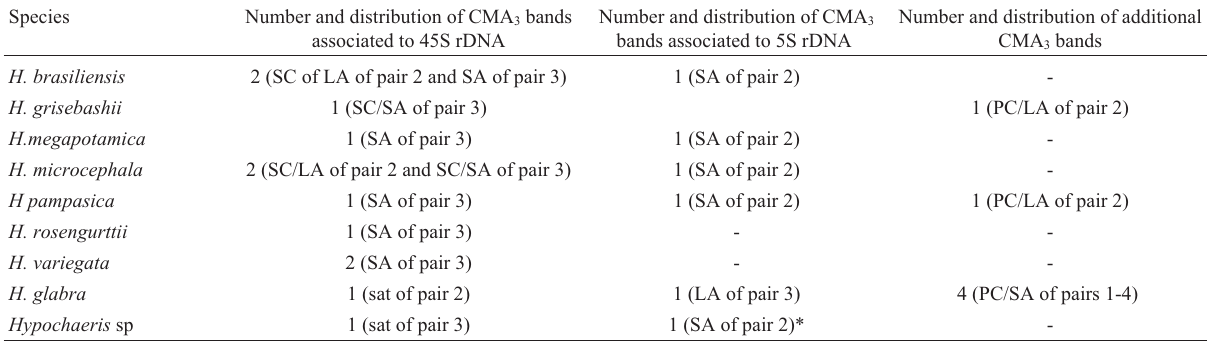
Table 2 - Distribution of CMA 3 positive bands and 45S and 5S rDNA loci per haploid genome of Hypochaeris species. Number and distribution of additional Number and distribution of CMA 3 Species Number and distribution of CMA 3 bands associated to 45S rDNA bands associated to 5S rDNA CMA 3